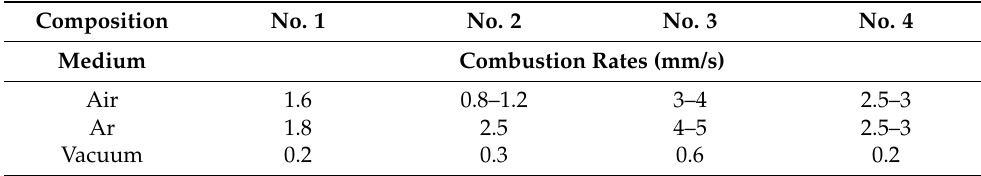
Figure 9. Specimens of composition No. 4 after combustion: ( a ) air; ( b ) argon; ( c ) vacuum. Table 3. Combustion rate in the W/PTFE/Al system.